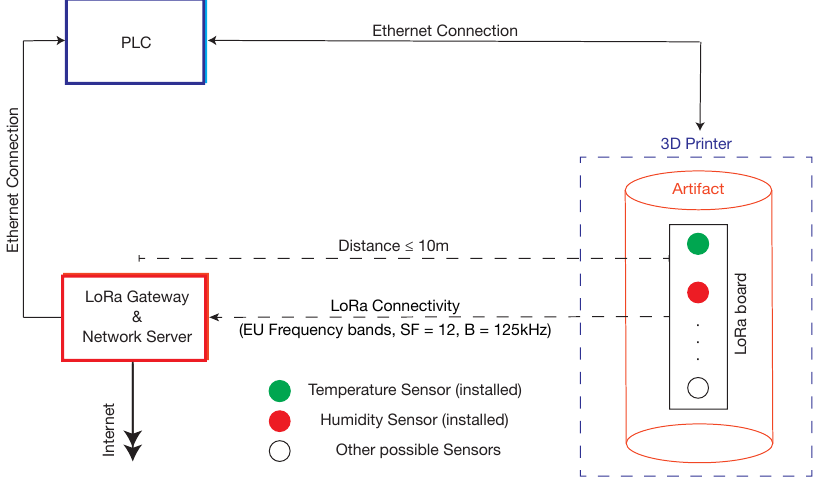
Figure 3. Sensor data transmission in the artifact production